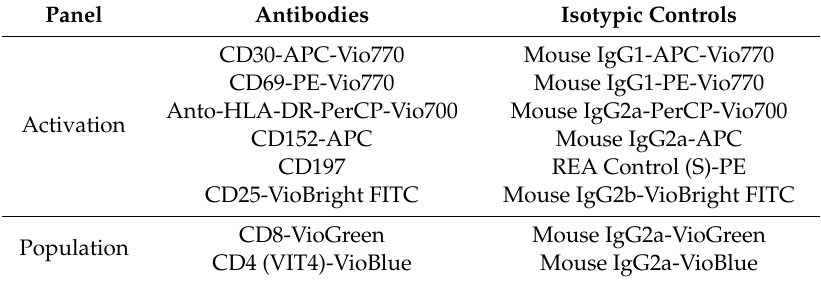
Table 3. List of the antibody panel used for flow